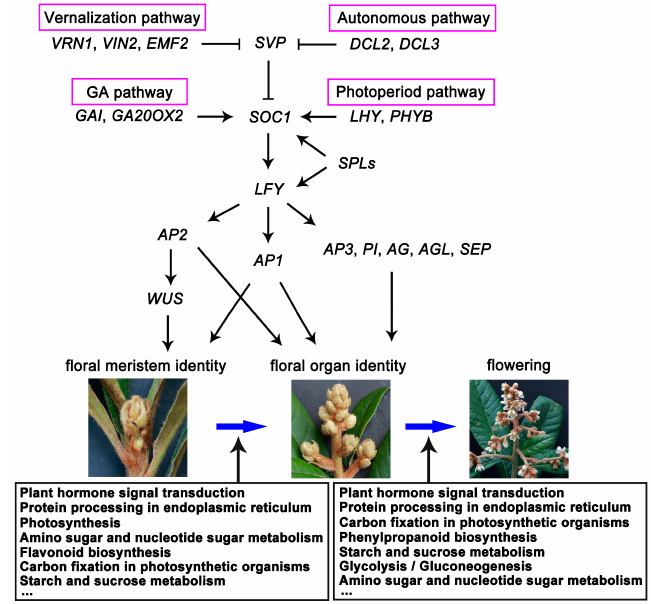
Figure 12. Schematic of the regulatory genes and metabolic pathways in flower development in